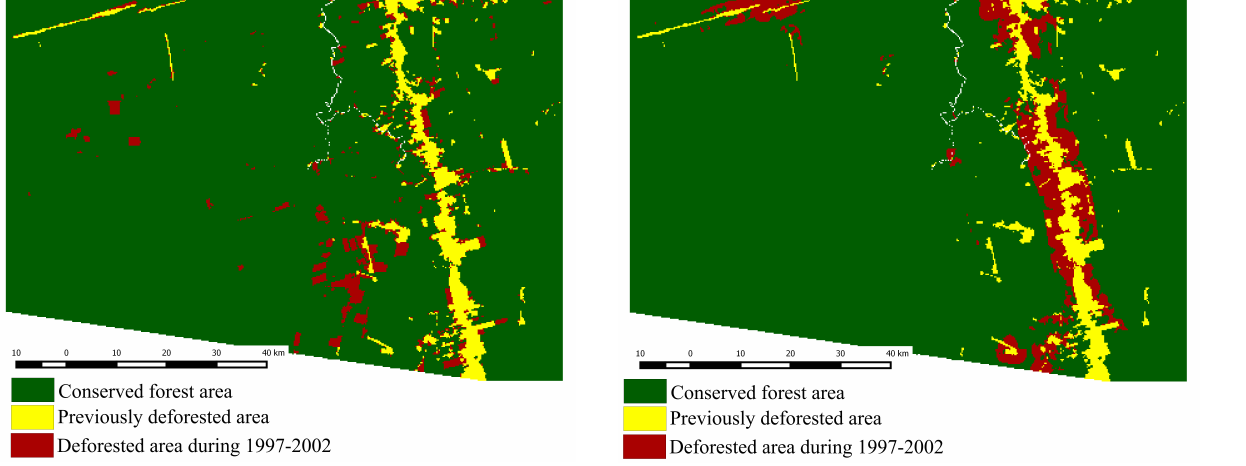
Figure 6: Simulated LUCC map (1997-2002) applying a thresh- old to the probabilities. Previously deforested area refers to forest area cleared before